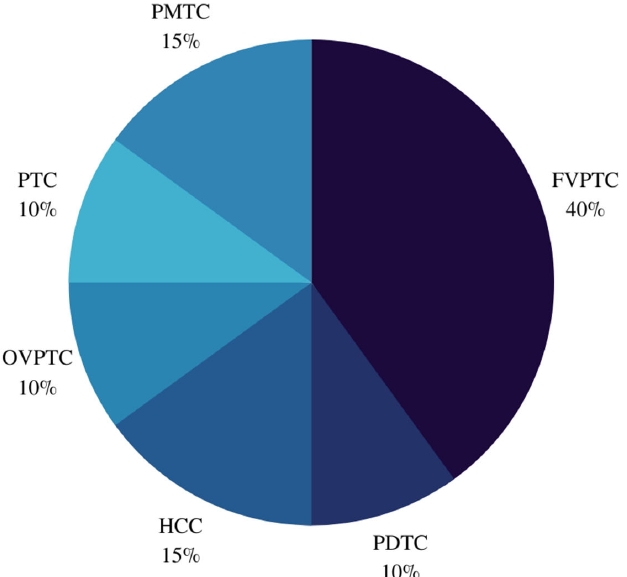
Figure 3. Histopathological diagnoses of malignant nodules. PMTC: Papillary thyroid microcarci ‐ noma; FVPTC: Follicular variant of papillary thyroid carcinoma; PDTC: Poorly differentiated thyroid carcinoma; HCC: Hurthle cell carcinoma; OVPTC: Oncocytic variant of papillary thyroid carcinoma; PTC: Papillary thyroid carcinoma.